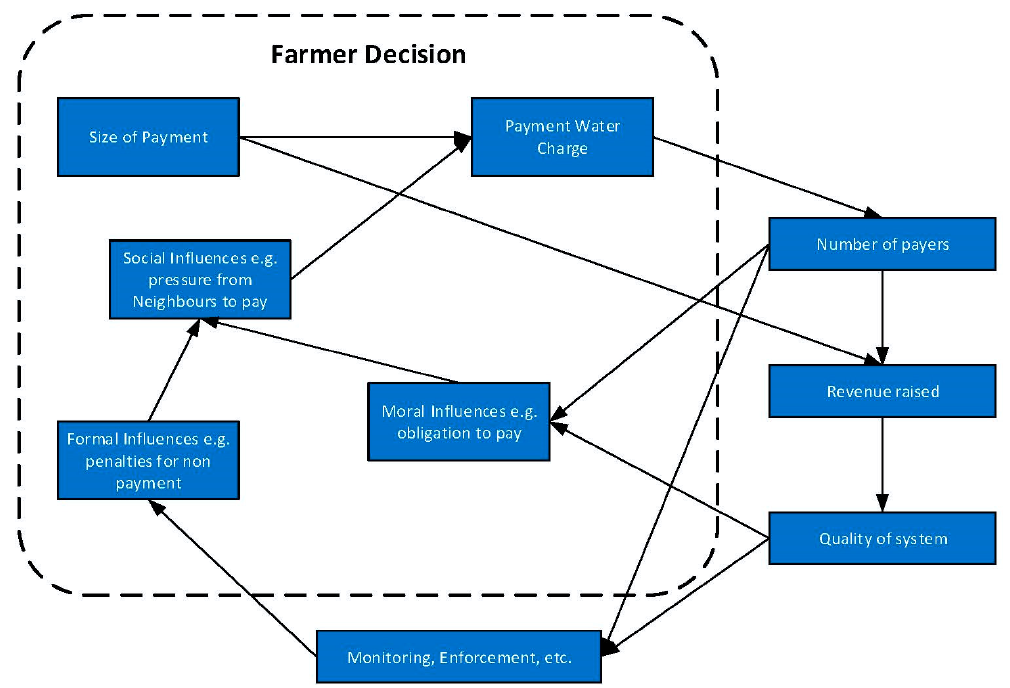
Figure 1. Farmer’s decision context.